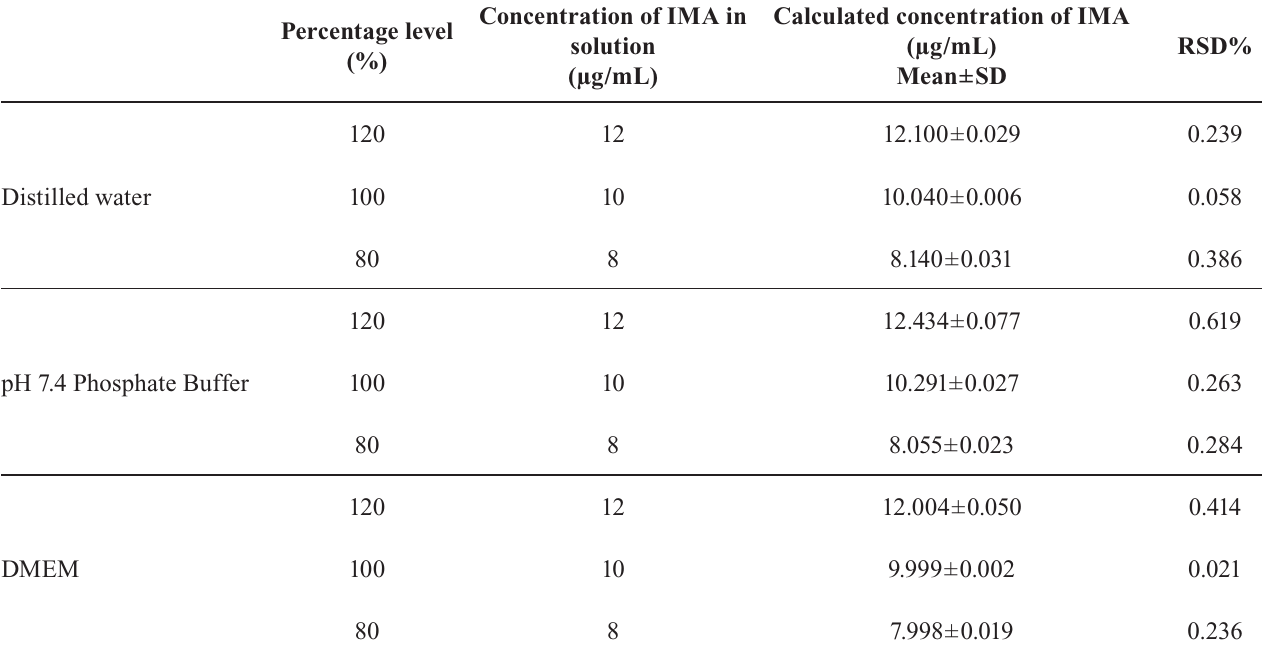
TABLE I - A ccuracy and recovery report of imatinib